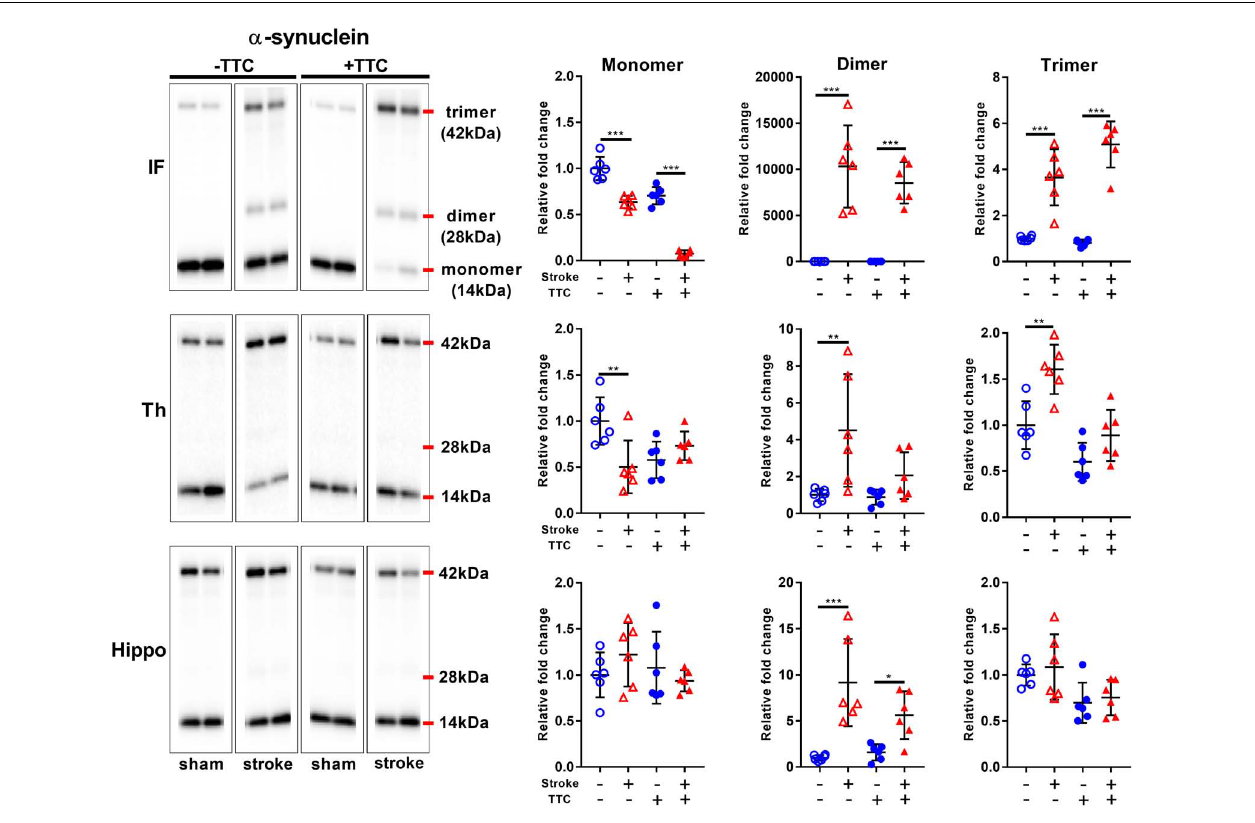
FIGURE 6 | Representative western blot and quantification of α -synuclein expression profile within the infarct (IF), thalamus (Th), and hippocampus (Hippo). Our analysis focused on the monomer (14 kDa), dimer (28 kDa), and trimer (42 kDa). Mean ± SEM (two-way ANOVA and Sidak’s multiple